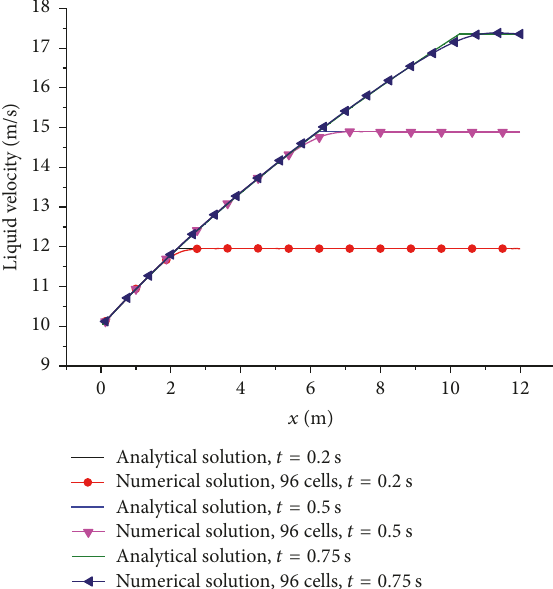
Figure 5: Numerical results from FOU scheme with 96 cells of liquid velocity compared with analytical results at time of 0.2, 0.5, and 0.75